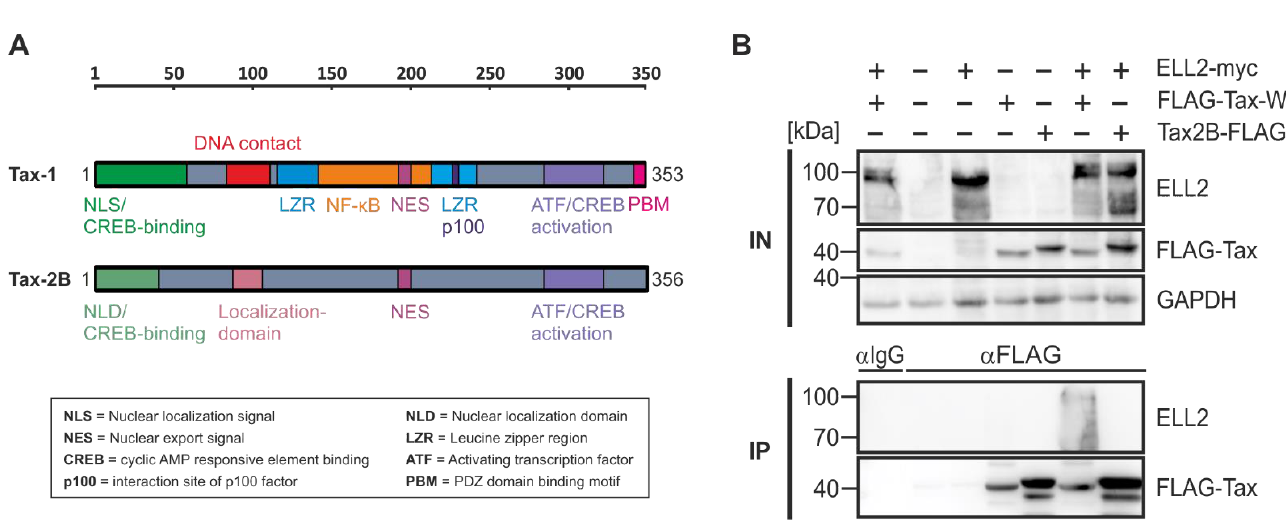
Figure 4. ELL2 interacts with Tax-1, but not with Tax-2B. ( A ) Schematic comparison of structural and functional domains of HTLV-1 Tax-1 and HTLV-2 Tax-2B. Numbers indicate amino acids of Tax. ( B ) 293T cells were transfected with expression plasmids pEF-ELL2-myc (ELL2-myc), pCAG-FLAG-Tax (FLAG-Tax-WT), and Tax-2B-FLAG (1 µg each) and supplemented with the respective empty control vectors pEF or pCAG-FLAG to a total amount of 2 μg of DNA, if necessary. After 48 h, cells were lysed, and 5% of the lysates were taken as input (IN) control. The co-immunoprecipitation (IP) was performed using anti-FLAG or IgG control antibodies. One representative immunoblot out of four independent experiments is shown using antibodies targeting ELL2, FLAG (for detection of Tax-1 and Tax-2), and GAPDH.